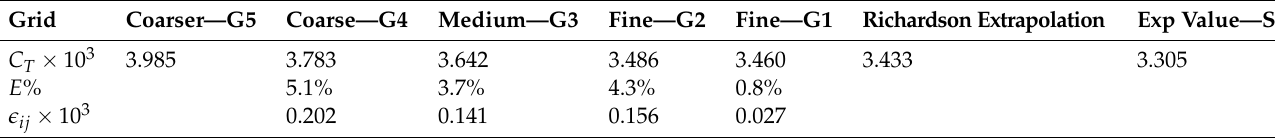
Table 8. Total resistance coefficient convergence for SUB-OFF submarine at Fr = 0.466 and H / D = 5.4. Grid